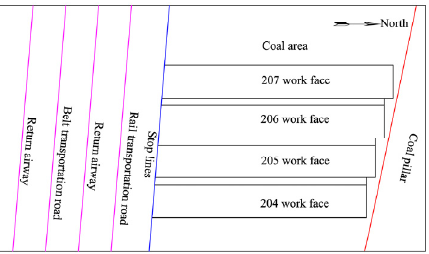
Figure 2. The diagrammatic sketch of working faces at the No. 2 panel area.